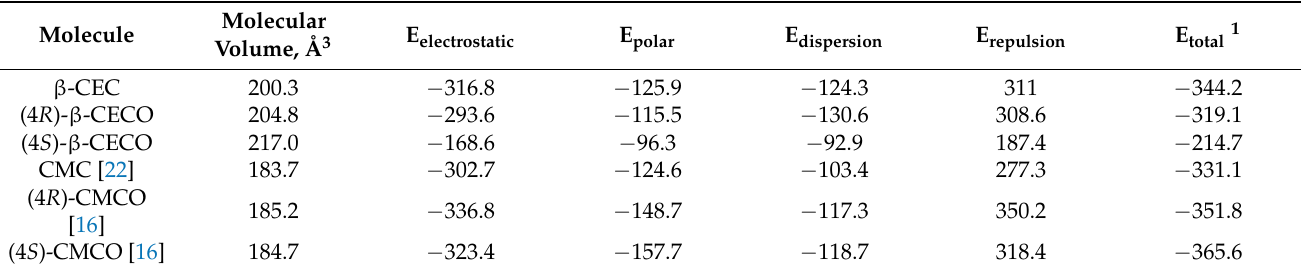
Table 2. Calculated intermolecular interaction energies E (kJ/mol) in crystalline 1 , 2 , 3 , and re- lated